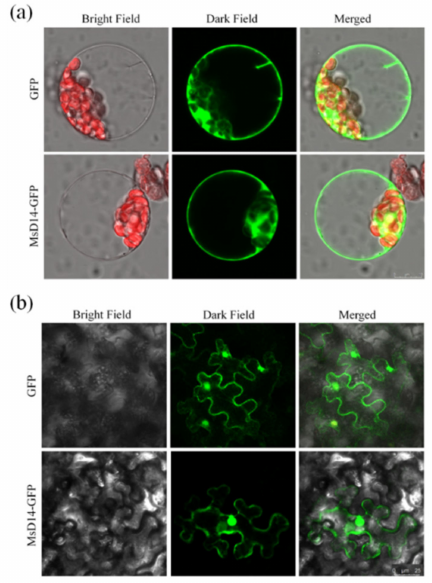
Figure 3. The subcellular localization of MsD14 in Arabidopsis protoplast ( a ) and tobacco epidermal cells ( b ). GFP represented the independent GFP protein; MsD14-GFP represented the fusion protein of MsD14 and GFP.